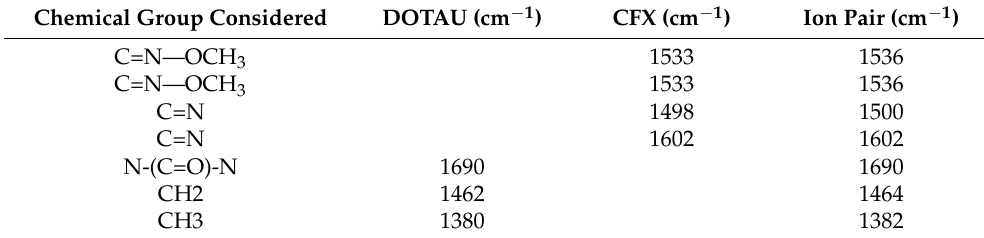
Table 2. IR vibrational bands of CFX, DOTAU and CFX–DOTAU ion pair. Chemical Group